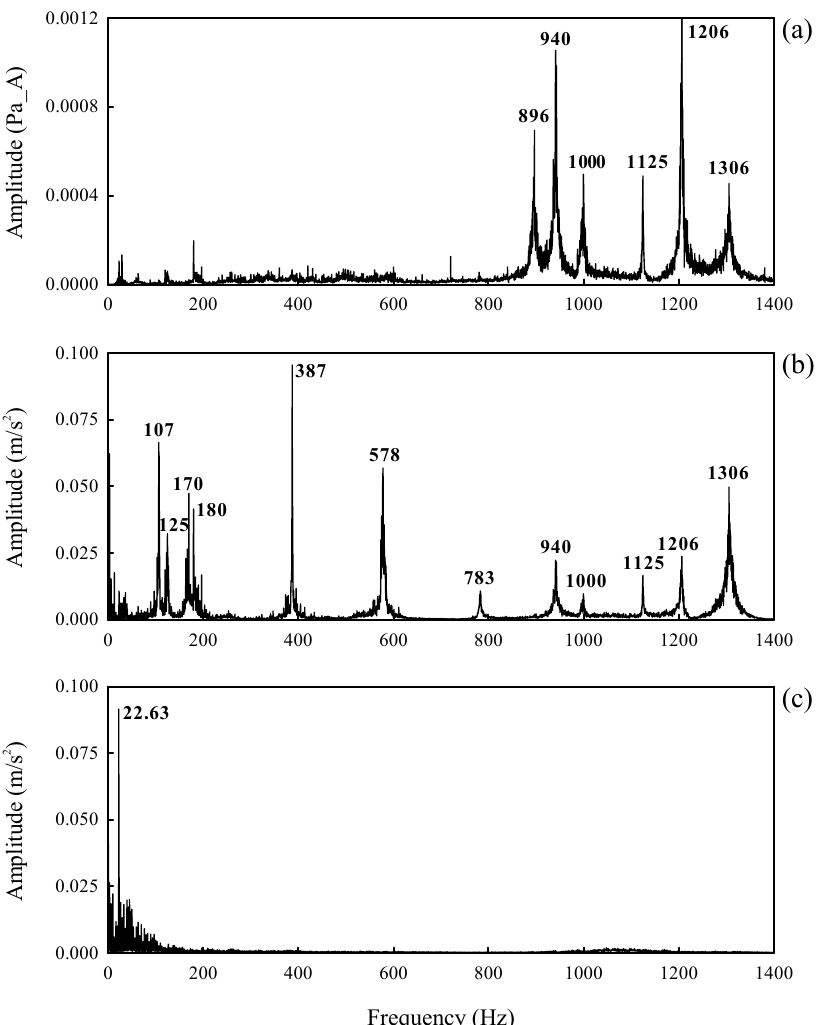
Figure 4. Frequency spectra for the noise and vibration of the assembled wheel bearing: ( a ) noise, ( b ) vibration of the dust shield, and ( c ) vibration of the outer ring.